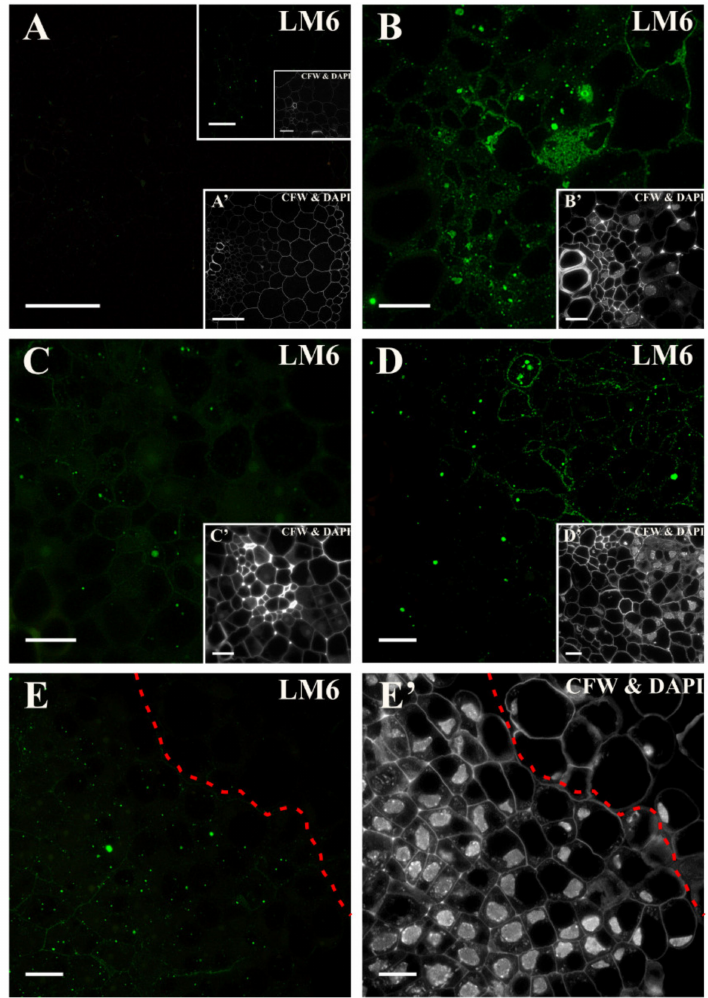
Figure 2. Distribution of the pectic epitope that is recognized by the LM6 antibody. ( A ) At the beginning of the culture, only a few punctate signals in the walls and cytoplasm in the cells of various tissues were detected. ( B ) After two days of culture, clear punctate signals in the cell walls and cytoplasmic compartments of the dividing cells and the vascular bundle were present. ( C ) On the fourth day of culture, the single punctate signals were detected in the dividing cells. ( D ) Presence of the signal on the fifth day in walls and in the cytoplasmic compartments of the cells with dense cytoplasm. ( E ) At the end of the culture (18 days), a punctate signal in the cytoplasmic compartments of the dividing cells in the surface layers of the stele was detected. The dashed line separates the occurrence of the epitope. ( A’ – E’ ) Calcofluor white (CFW) and DAPI staining of the section shown on A – E . Scale bars: A , A’ —50 µ m; inset—10 µ m; B – E , B’ – E’ —10 µ